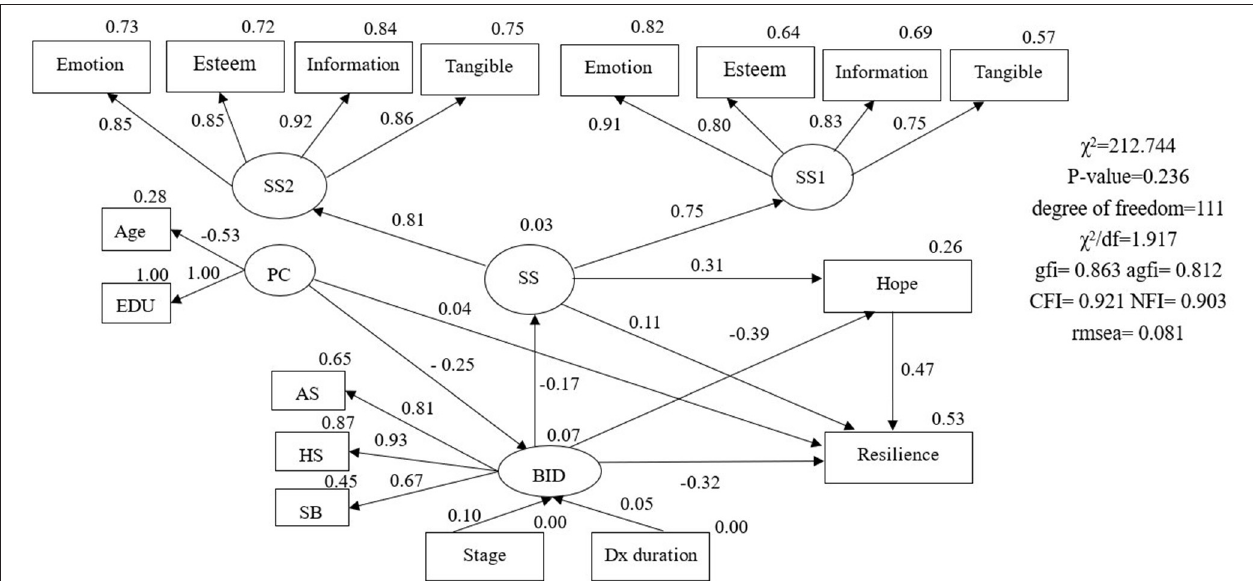
FIGURE 2 | Hypothesized model with standardized estimates. PC, personal characteristic; EDU, education; BID, body image distress; SB, social barriers; AS, physical appearance and sexual life; HS, health and strength; Stage, disease stage; Dx duration, time since breast cancer diagnosis; SS, social support; SS1, social support from family and friends; SS2, social support from health professionals; = latent variable;